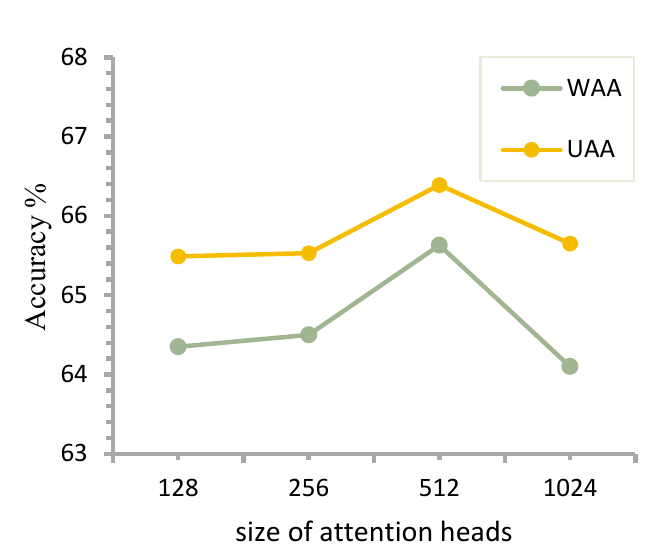
Figure 9. Comparison of different attentional head sizes in MHA-CRNN structures.